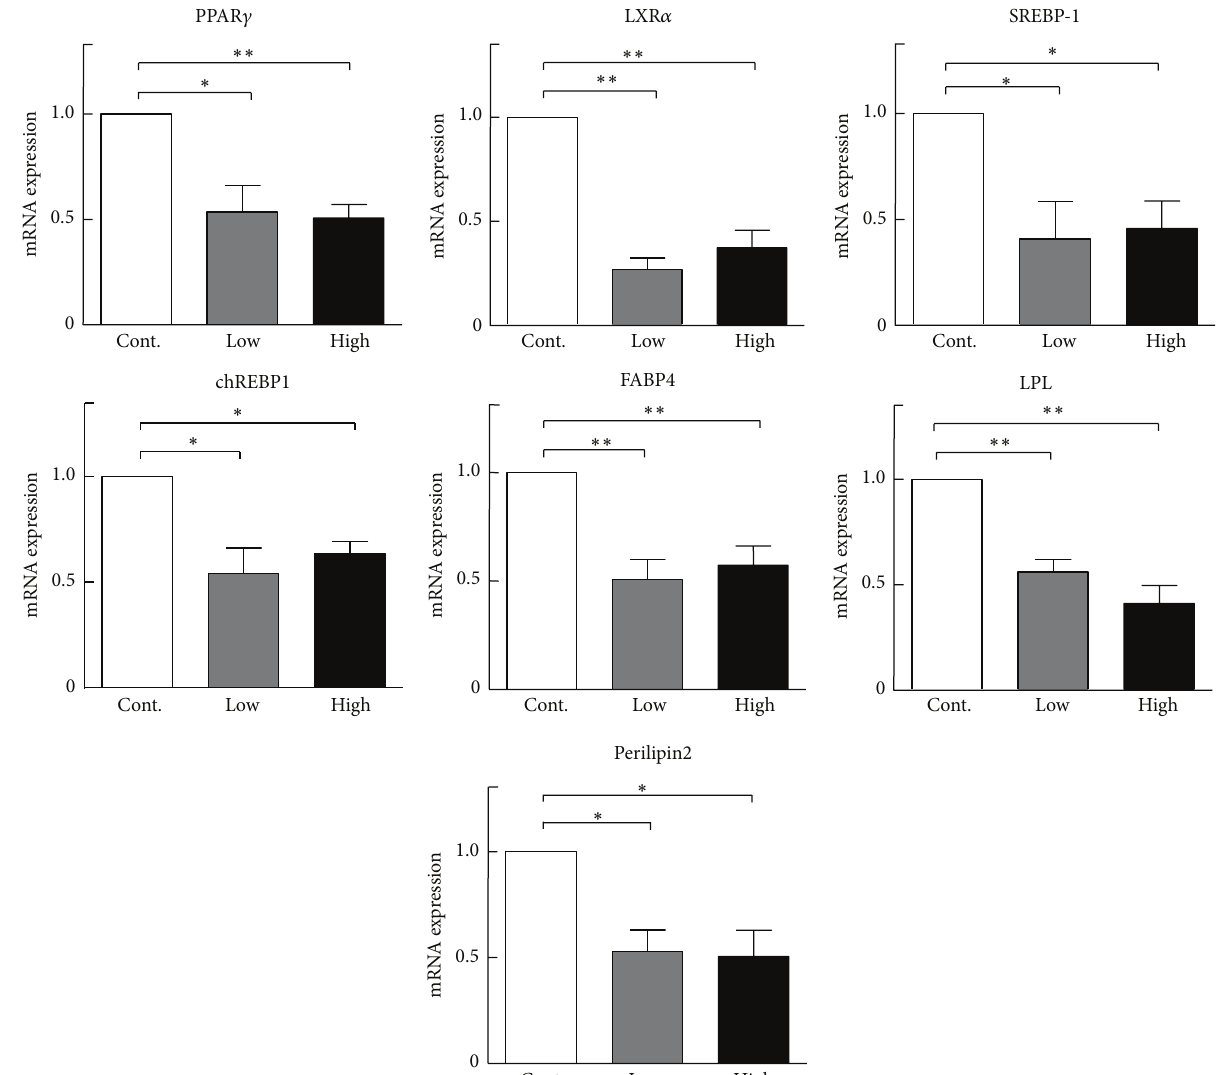
Figure 7: Real time PCR results of lipid and glucose metabolism related genes mRNA expressions levels in the liver. 𝑛 = 3 for each group (pooled samples). Data are expressed as the mean ± SEM. ∗ 𝑃 < 0.05 , ∗∗ 𝑃 < 0.01 versus control. PPAR 𝛾 : peroxisome proliferator-activated receptor gamma; LXR 𝛼 : nuclear receptor subfamily 1, group H, member 2; SREBP-1: sterol regulatory element binding transcription factor 1; chREBP1: WS basic-helix-loop-helix leucine zipper protein 1; FABP4: fatty acid binding protein 4; LPL: lipoprotein